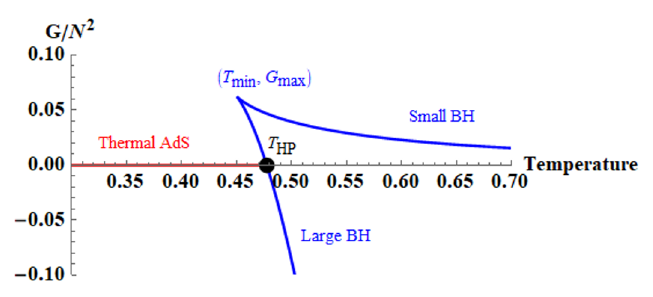
Figure 1 . AdS-Schwarzschild phase diagram ( Φ = 0 , Ω a,b = 0 ). The cusp is at the minimal √ temperature T = , and the maximal free energy G 2 min π meets the thermal AdS phase at the Hawking-Page temperature T